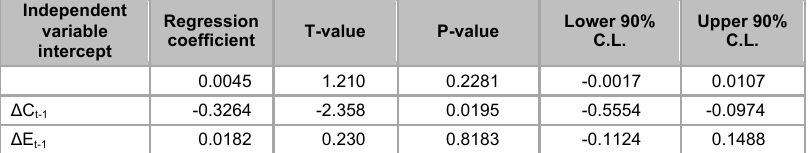
Exchange rate as dependent variable Independent